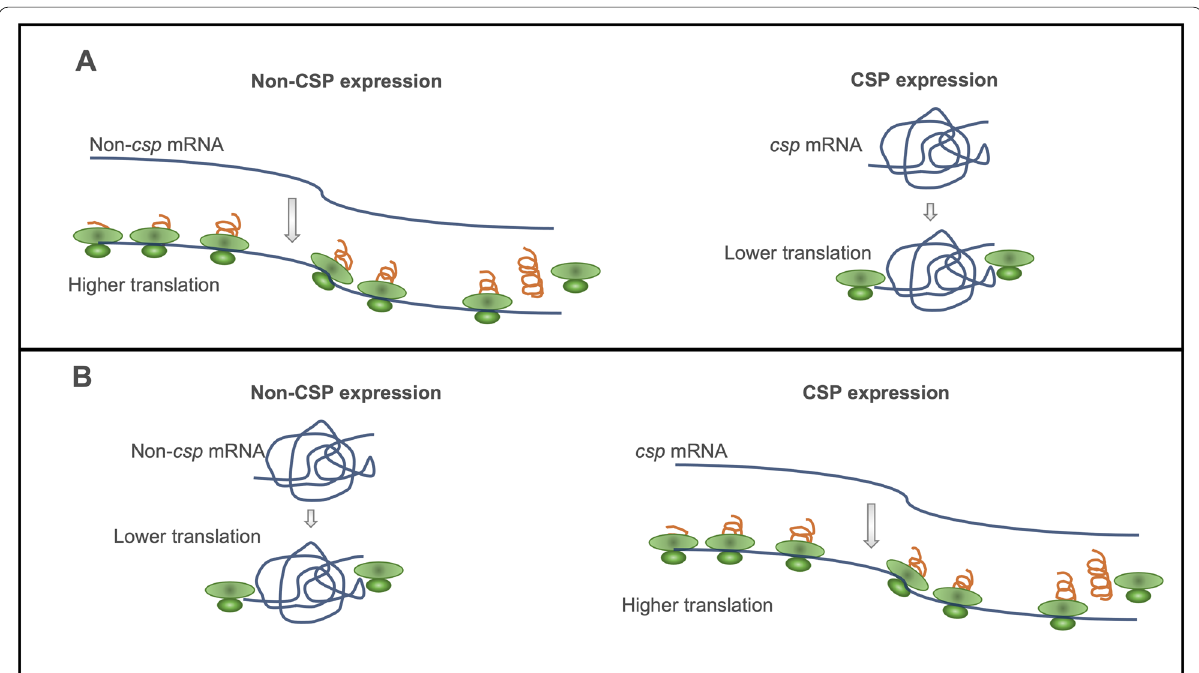
Fig. 2 Effect of sub‑physiological temperatures on CSP translation. A Protein translation at physiological temperature where the concentration of non‑CSPs increases while the CSPs remain at low levels. B The cellular response under cold shock involves modulation of protein expression where the concentration of CSPs increases while the non‑CSPs diminishes. Reduced expression of non‑CSPs is linked to repression of non‑ csp mRNA translation, leading to slower growth and cell cycle arrest. CSP overexpression is linked to higher csp ‑mRNA translation due to a secondary structure change that facilitates ribosome docking. CSP overexpression allows cell growth to continue under cold stress. CSP: cold‑shock